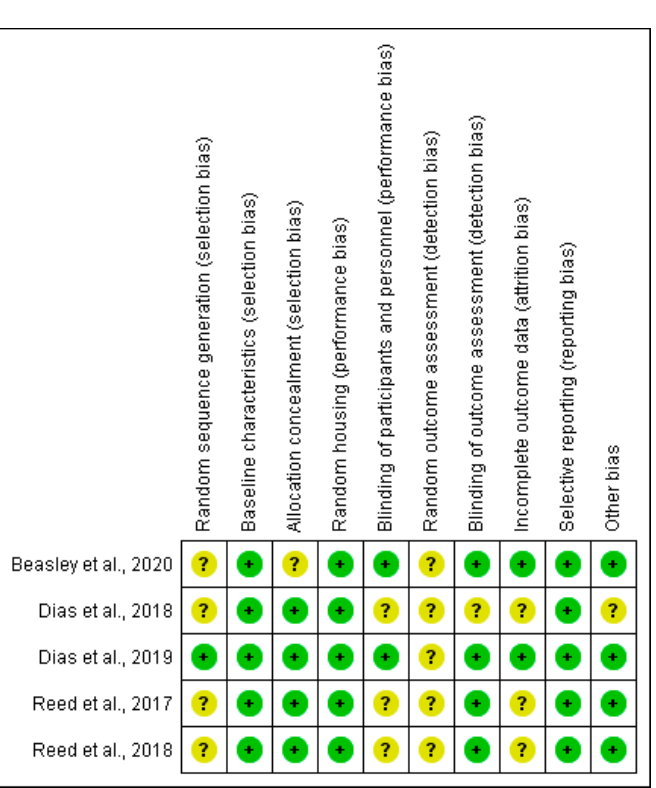
Figure 2. Risk of bias summary: review authors’ judgments about each risk of bias item for each included study. +, low risk; ?, unclear.